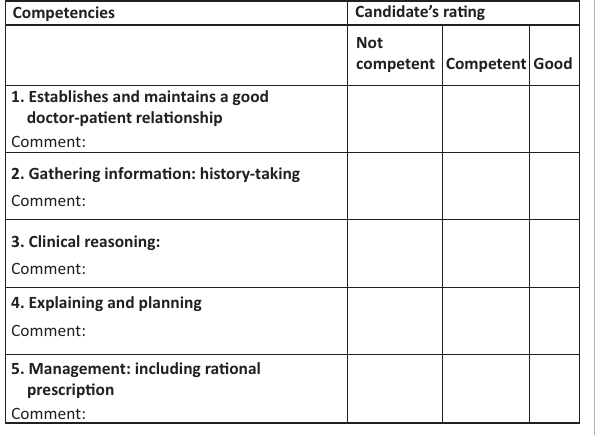
FIGURE 4: Objectively structured clinical examination clinical scenario.